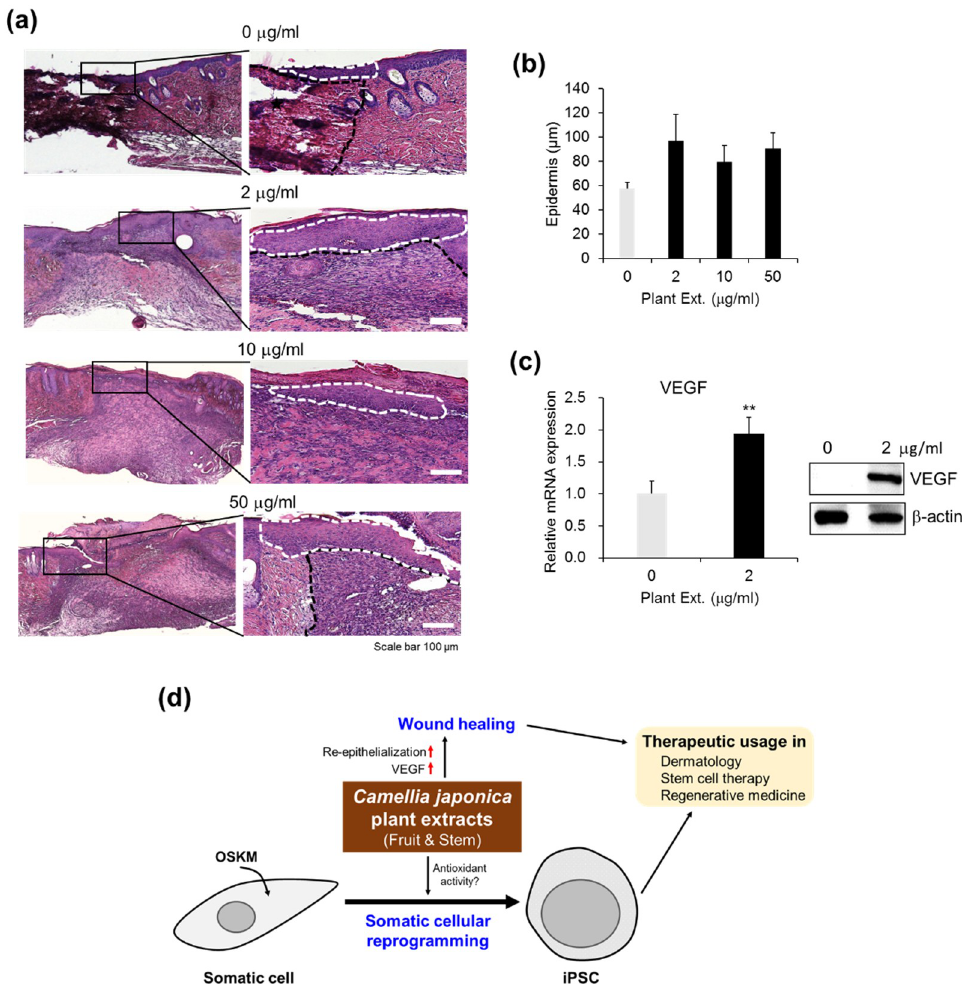
Figure 6. Re-epithelialization and vascular endothelial growth factor (VEGF) upregulation by CJ extracts in wound healing. ( a ) Histological examination of mice treated with CJ extracts No. 34 and No. 1319 (0–50 mg/mL) on the day 7 after wounding. The photographs are representative of three wounds stained with hematoxylin and eosin in each group. Dotted lines denote the route of re-epithelialization. ( b ) The length of the epidermis based on re-epithelialization from the wound edges was analyzed histomorphometrically. The results are presented as the mean ± SEM ( n = 8). ( c ) VEGF expression in the wound tissues on day 7 postsurgery was quantified by qPCR analysis (left) and by Western blot analysis (right). VEGF mRNA expression was normalized to GAPDH. The results are presented as mean ± SEM ( n = 4) and ** p < 0.01. ( d ) Putative model of CJ ‑extract‑mediated